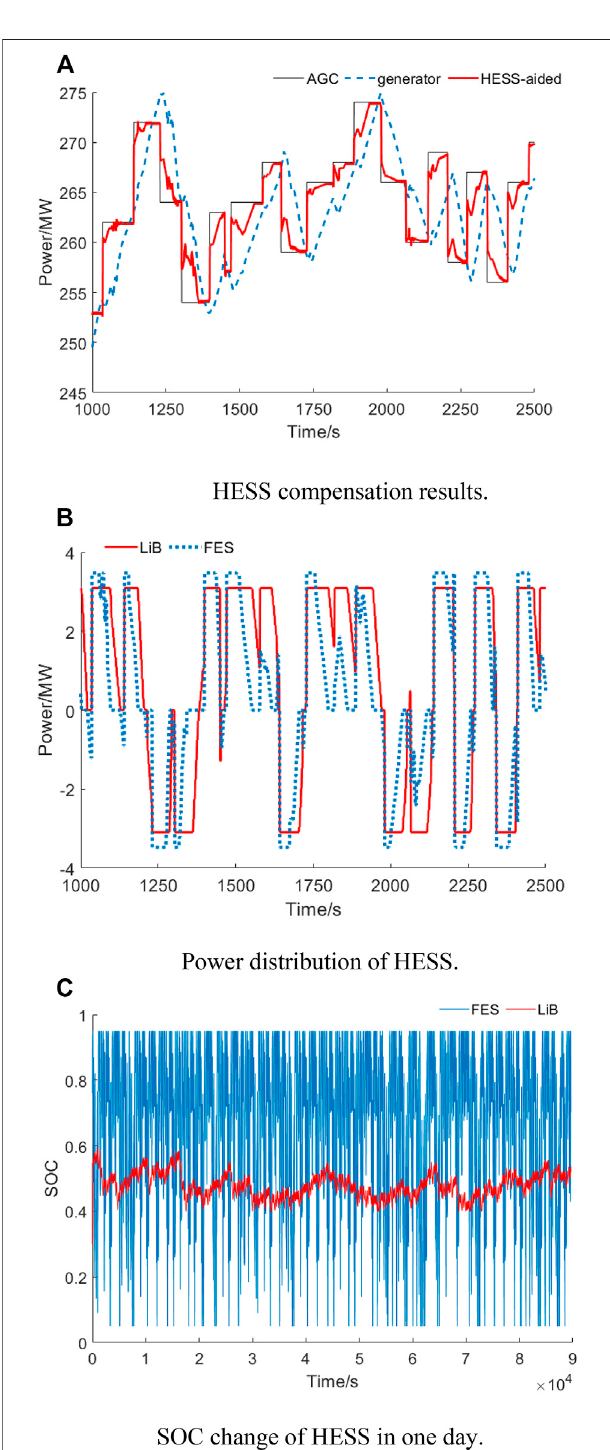
FIGURE 4 | Results of the lower-layer optimization control (partial results). (A) HESS compensation results. (B) Power distribution of HESS. (C) SOC, change of HESS, in 1